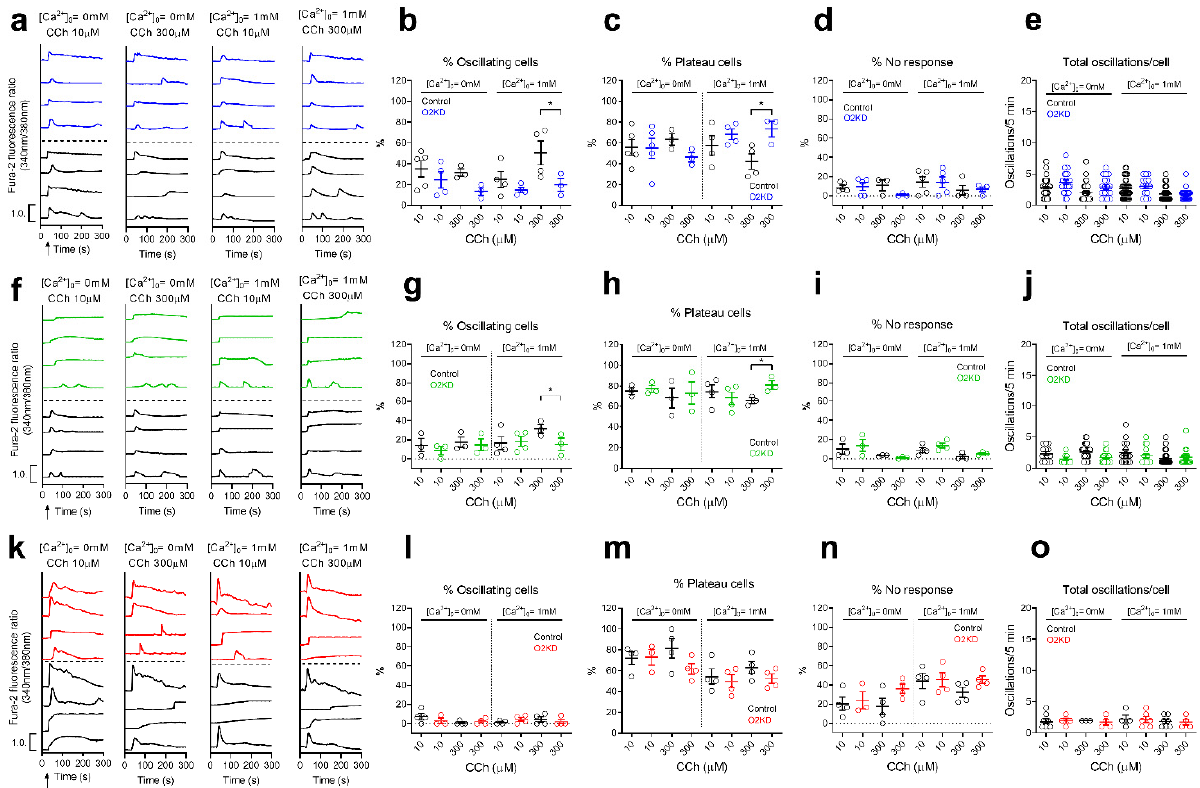
Figure 3. Ca 2+ oscillations induced by CCh in breast cancer cells are not affected by Orai2 knockdown. ( a , f , k ) Representative Ca 2+ oscillations in response to 10 or 300 µ M CCh measured using Fura2 in BT20 ( a ), SKBR3 ( f ) and T47D ( k ) cells transfected with esiOrai2 (color traces) or non-specific siRNA (black traces; control). Cells were superfused with HBSS containing 1mM Ca 2+ and stimulated with 10 or 300 μ M CCh at 1 min (indicated by arrow in the first panel). Representative traces from 4 cells/condition were chosen to represent the datasets. ( b – d , g , h , l – n ) Quantification of the per- centage of oscillating cells ( b , g , l ), percentage of plateau cells ( c , h , m ), and percentage of non-re- sponding cells ( d , i , n ) for data presented in ( a , f , k ) ( n = 3–5; n-values correspond to independent experiments). For data presented in ( e , j , o ), from left to right, n = 52, 25, 49, 18, 40, 15, 79 and 25 for panel ( e ), n = 13, 7, 28, 18, 16, 15, 49 and 18 for panel ( j ) and n = 10, 4, 3, 4, 3, 7, 7 and 4 for panel ( o ); n -values correspond to individual cells). The total number of cells analyzed in every condition is shown in Table S1. Scatter plots are represented as mean ± SEM and were statistically analyzed using ANOVA with multiple comparisons (Tukey test) to cells transfected with scramble plasmids (* p < 0.05). 2.4. Orai2 Modulates NFAT1 and NFAT4 Nuclear Translocation SOCE has been reported as an essential regulator of NFAT nuclear translocation [27,28]. The nuclear translocation of NFAT1 has been shown to require robust SOCE acti- vation, while NFAT4 nuclear translocation has been associated with more subtle SOCE activation [29,30]. In order to ascertain the functional role of Orai2 on NFAT1 nuclear translocation and activity, we expressed an NFAT1-responsive GFP construct (NFAT re- porter), where the fluorophore is controlled by a CMV promoter and tandem repeats of the NFAT consensus binding site as previously described [31]. Cells were stimulated with TG (1 μ M) or CCh (10 and 300 μ M) in the presence of 1 mM extracellular Ca 2+ for 120 min, and the abundance of GFP as indicated by the intensity of the signal was monitored. As shown in Figure 4a,b, in BT20 cells treated with non-specific siRNA, the GFP intensity was significantly enhanced by cell treatment with TG ( p < 0.001). Furthermore, cell stimulation with CCh (300 μ M) significantly enhanced GFP intensity (Figure 4a,b; p < 0.01), while a low concentration of CCh (10 μ M) was unable to significantly enhance NFAT1 nuclear